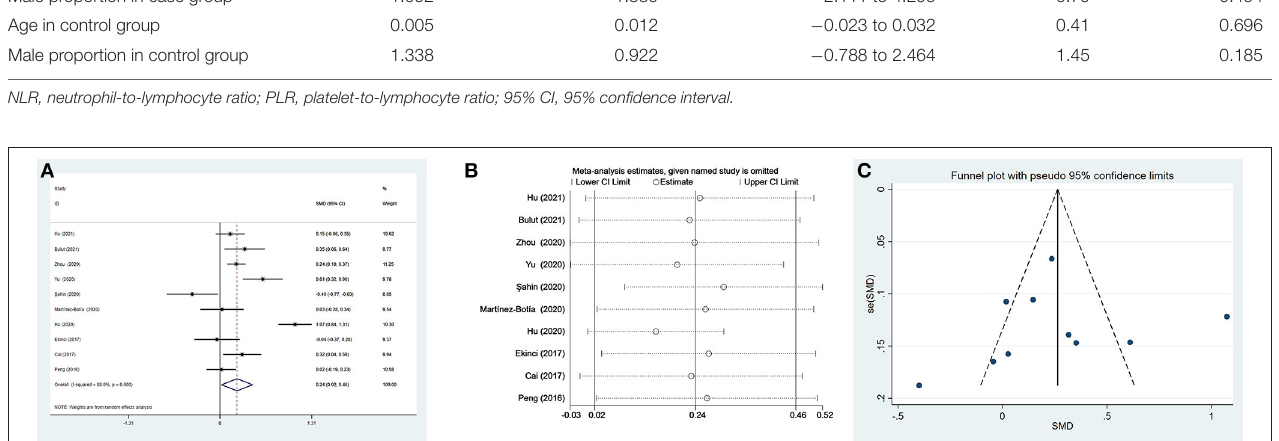
FIGURE 3 | Results of meta-analysis on PLR between depressed patients and controls. (A) Forest plot of standardized mean difference in PLR between depressed patients and controls. The PLR values were distinctly higher in depressed patients than in controls (SMD = 0.24, 95% CI: 0.02–0.46, p < 0.05). Due to significant heterogeneity among studies ( I 2 = 88.0%, p < 0.001), the random-effects model was applied. (B) Sensitivity analysis indicated an unstable result of this meta-analysis. (C) The funnel plot appeared to be symmetric, which suggested no publication bias in studies reporting the values of PLR in depressed patients and controls.